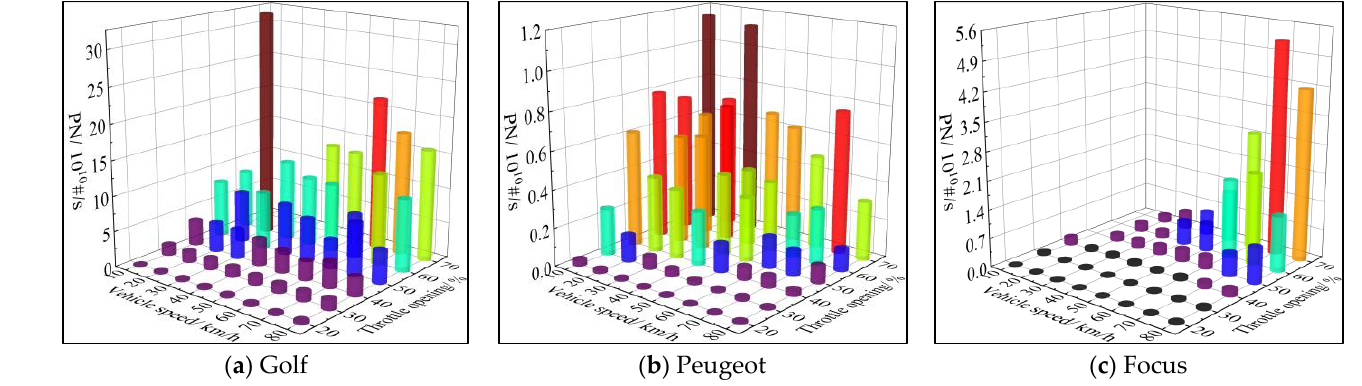
Figure 7. PN emission rates vs. vehicle speed and throttle opening.